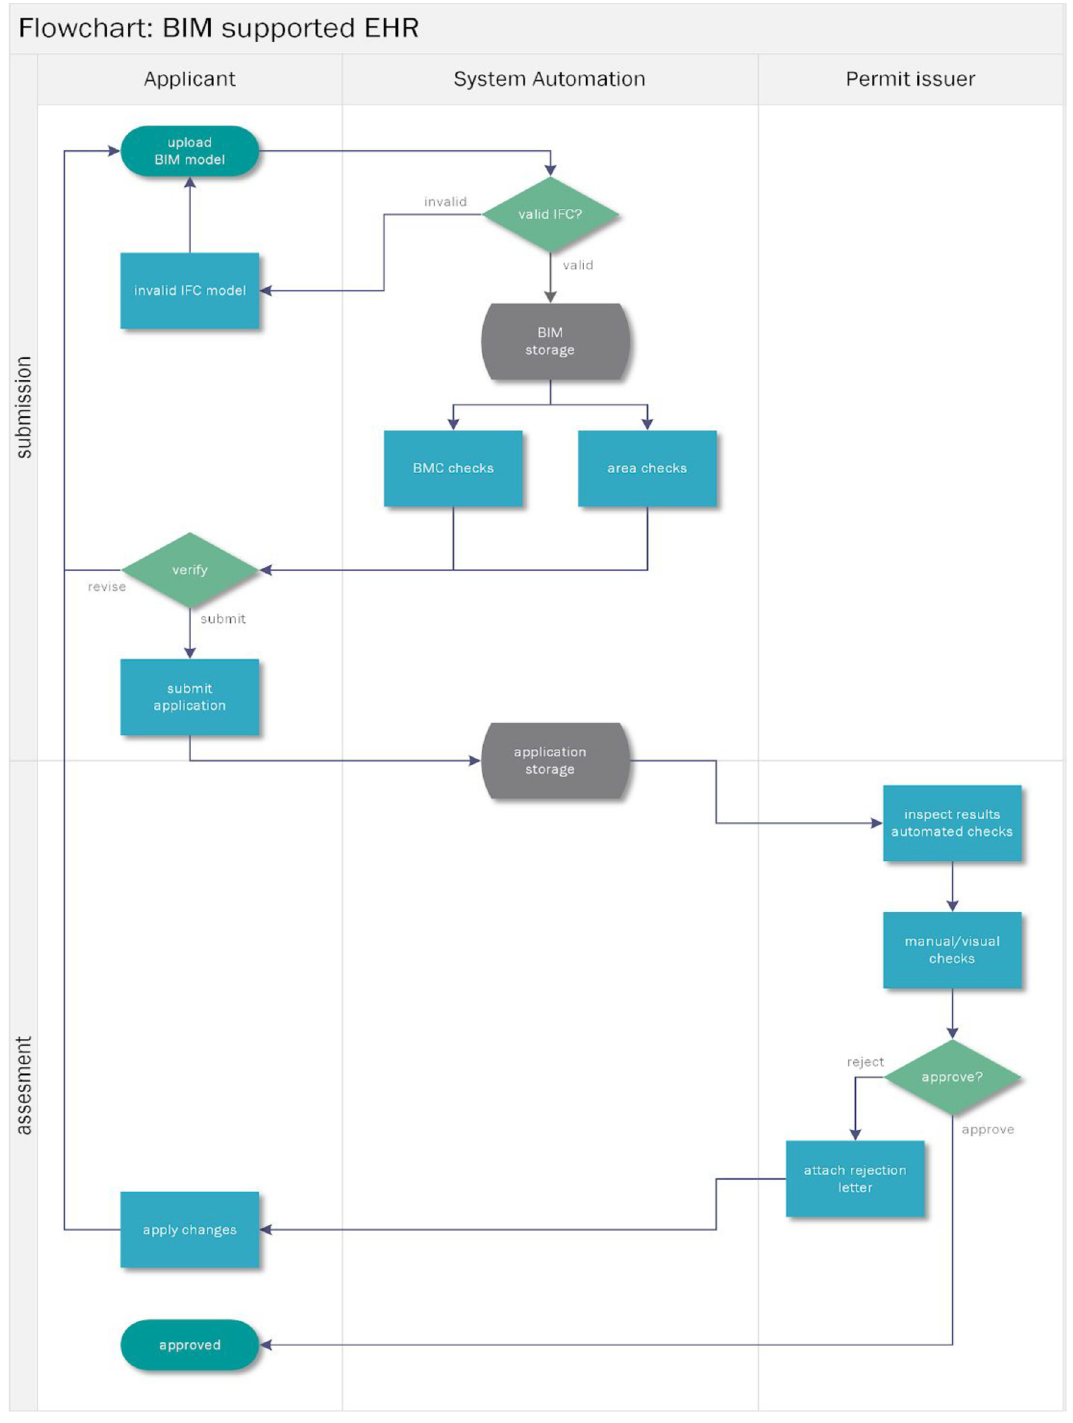
Figure 5. Proof of concept flowchart (source: Estonian Ministry of Economic Affairs and Communi- cation (MoEAC), and Future Insight Group [49]).